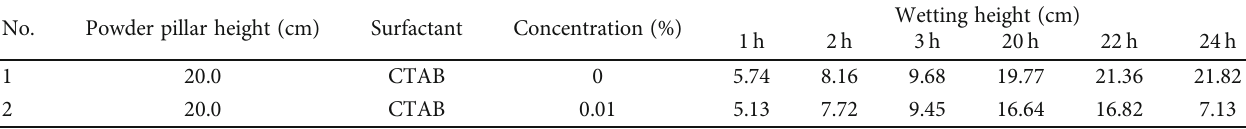
Table 4: Experimental results of the coal ’ s gas-water relative permeability before and after surfactant adsorption. Before surfactant adsorption